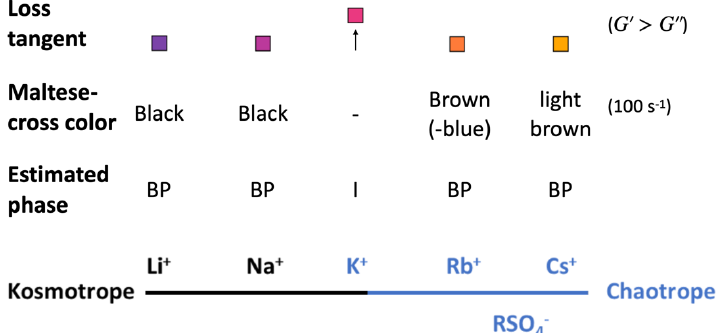
Figure 7. Ordering of the alkali metal cations, and sulfate ions in their kosmotrope and chaotrope character. Abbreviations: BP-biphasic, I-isotropic. The arrow indicates a higher loss tangent value for K + than for other cations.